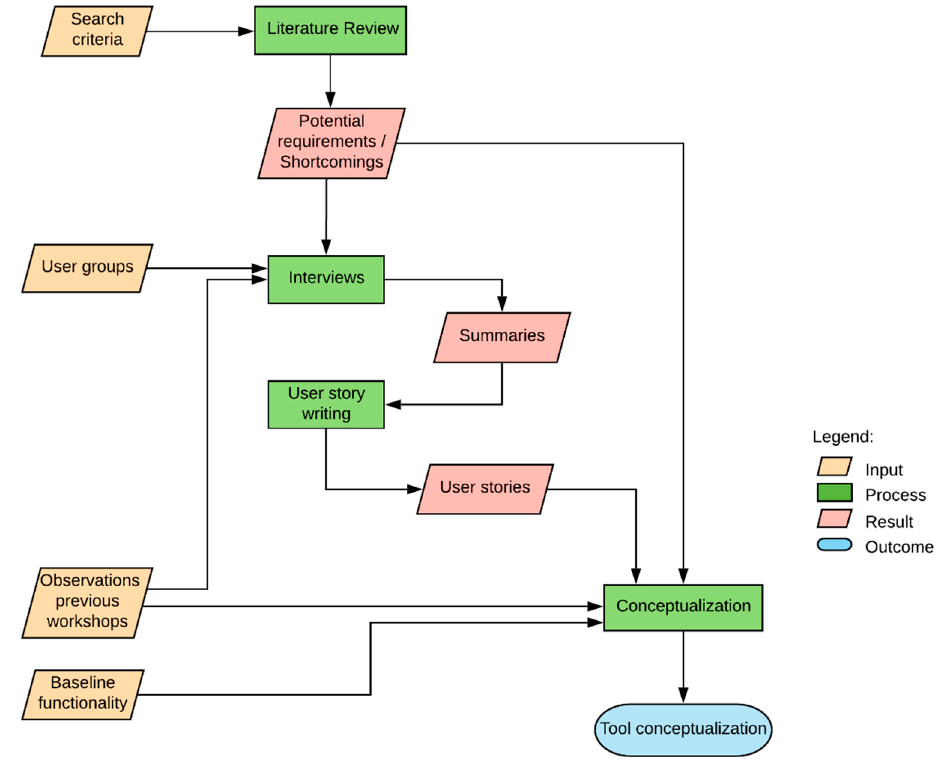
Figure 3. Methodology overview.